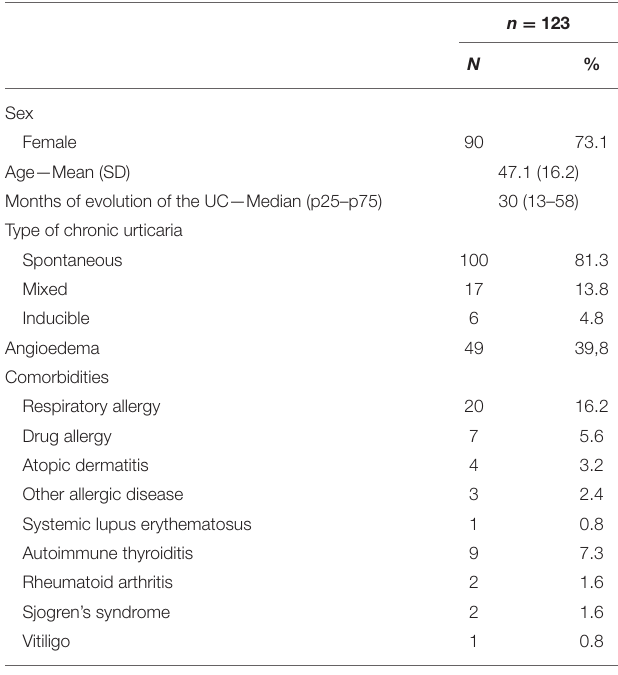
TABLE 1 | Demographic and clinical characteristics of patients with chronic urticaria.